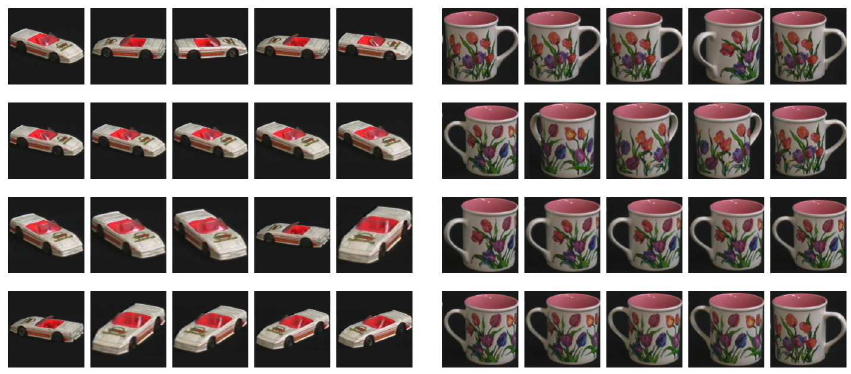
Figure 3. The left image shows car category results, while the right image shows cup category results.